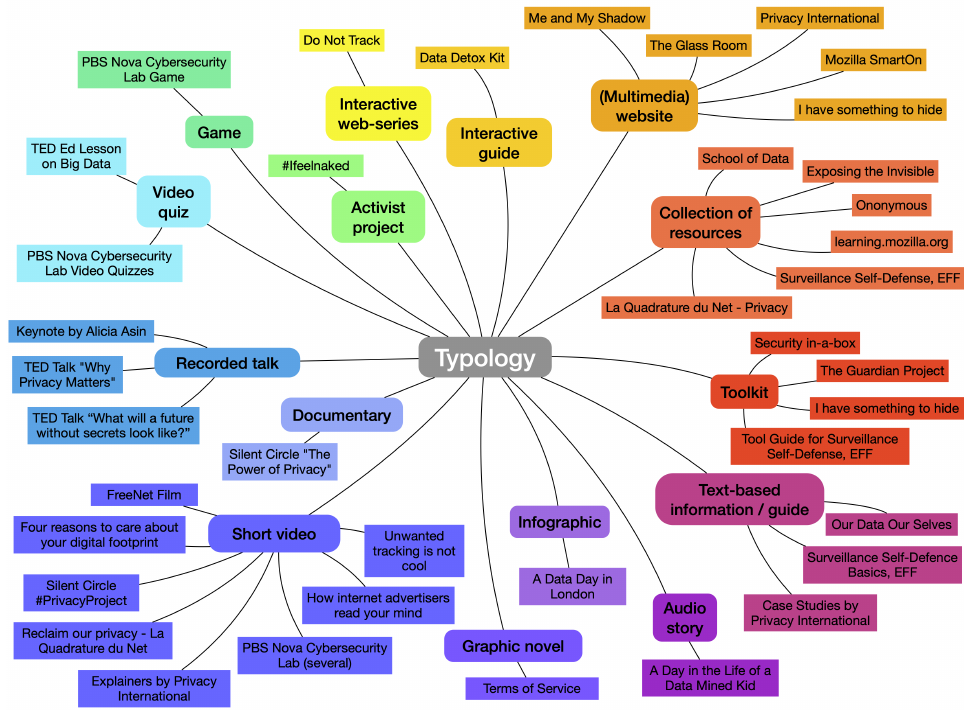
Figure 3: Typology of all identified data literacy tools and associated